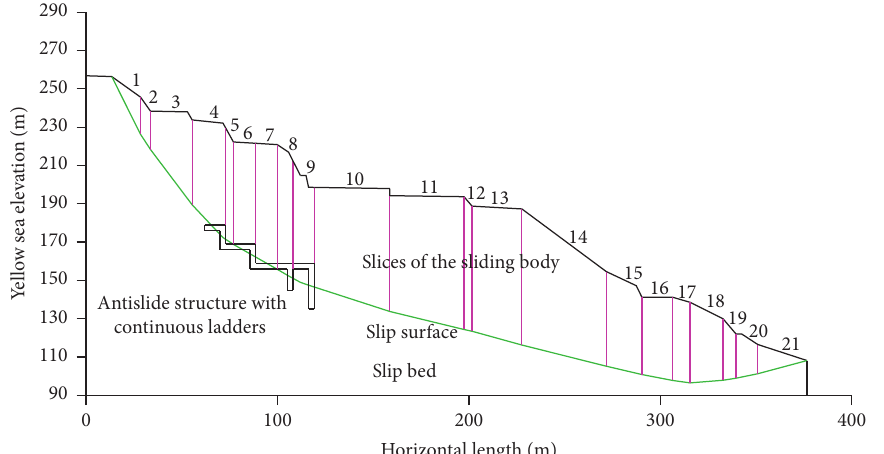
Figure 11: The layout of the ASCL in the Houzishi landslide. According to the unbalanced thrust method, the sliding body is divided into 21 sticks to calculate the landslide thrust and resistance along the vertical direction. The horizontal axis represents the horizontal length of the landslide, while the vertical axis represents the Yellow Sea elevation of the